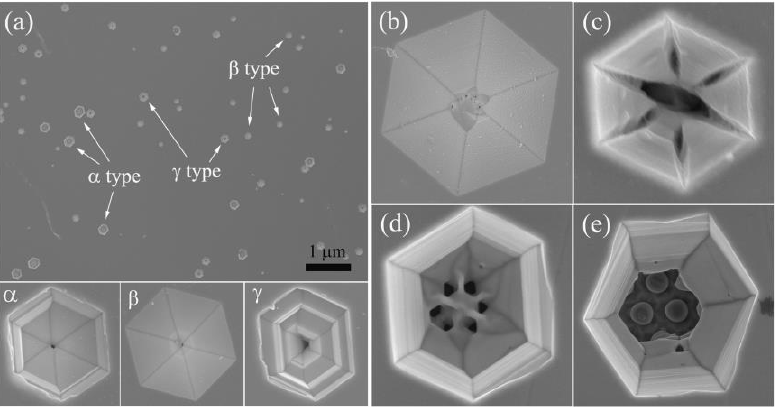
Figure 6. ( a ) SEM images of Sp surface at 80 °C etching by KOH for 12 min. ( b – e ) Plan-view SEM images of the β -type dislocation which show the etching evolution of wurtzite AlN surface.